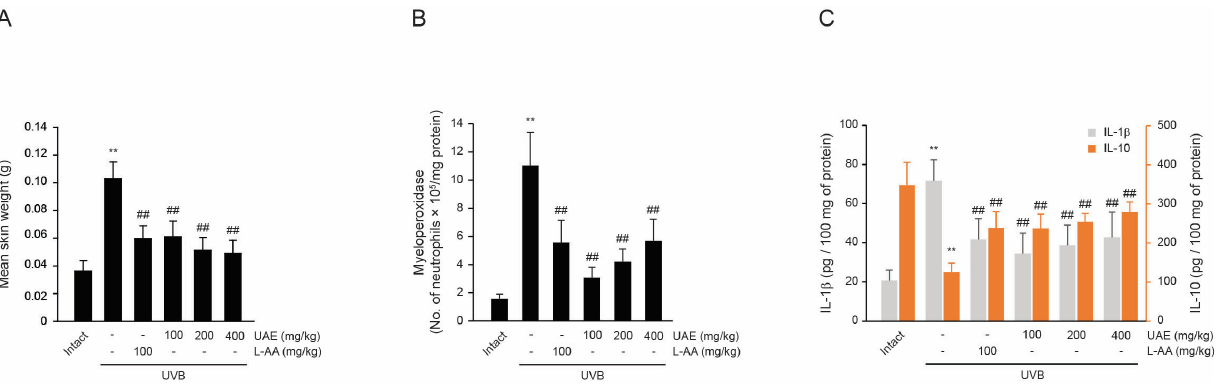
Figure 3. Effects of UAE on UVB-induced skin inflammation. ( A ) Skin edema was evaluated with the weight of a constant area (6 mm diameter) of dorsal back of mice. Data are presented as mean weight of skin samples (g). ( B ) Myeloperoxidase (MPO) activities for skin neutrophil content, and ( C ) IL-1 β and IL-10 levels were determined in dorsal back skin tissue. Results are presented as mean ± SD (n = 10, signi fi cant di ff erence vs. intact control; ** p < 0.01, vs. UVB-irradiated control mice; ## p < 0.01).